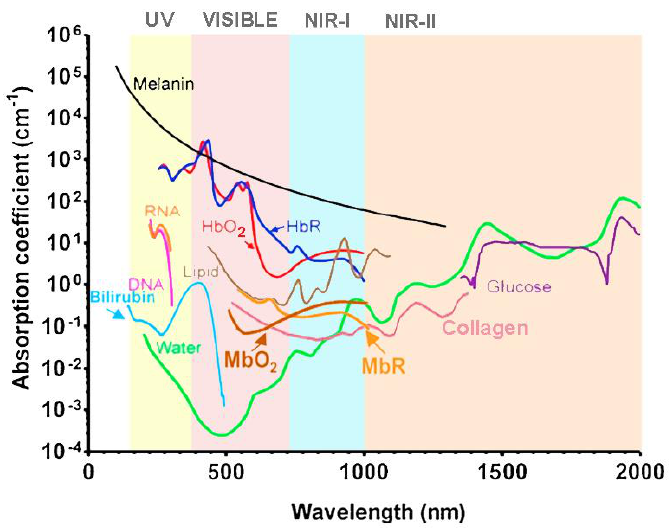
Figure 4. Absorption coefficient versus wavelength for different endogenous contrast agents. Adapted from [12,23,30,44].